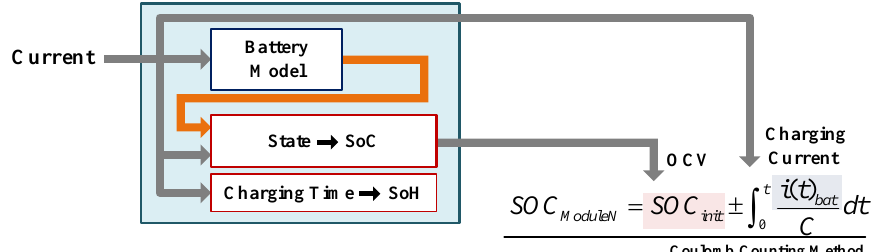
Figure 3. Battery management system (BMS) sequence for the state of health (SoH) and state of charge (SoC) calculations.